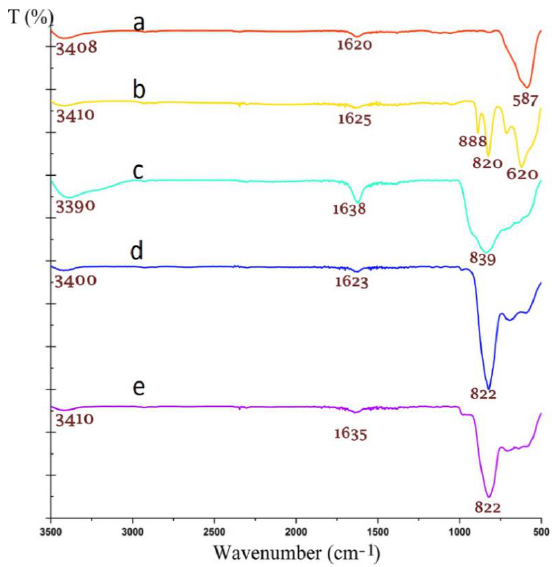
Figure 5. FTIR spectra of ( a ) Fe 3 O 4 , ( b ) the S 1 sample, ( c ) the S 4 sample before calcination, ( d ) the S 4 sample after calcination, and ( e ) S 4 after the photodegradation of MB.